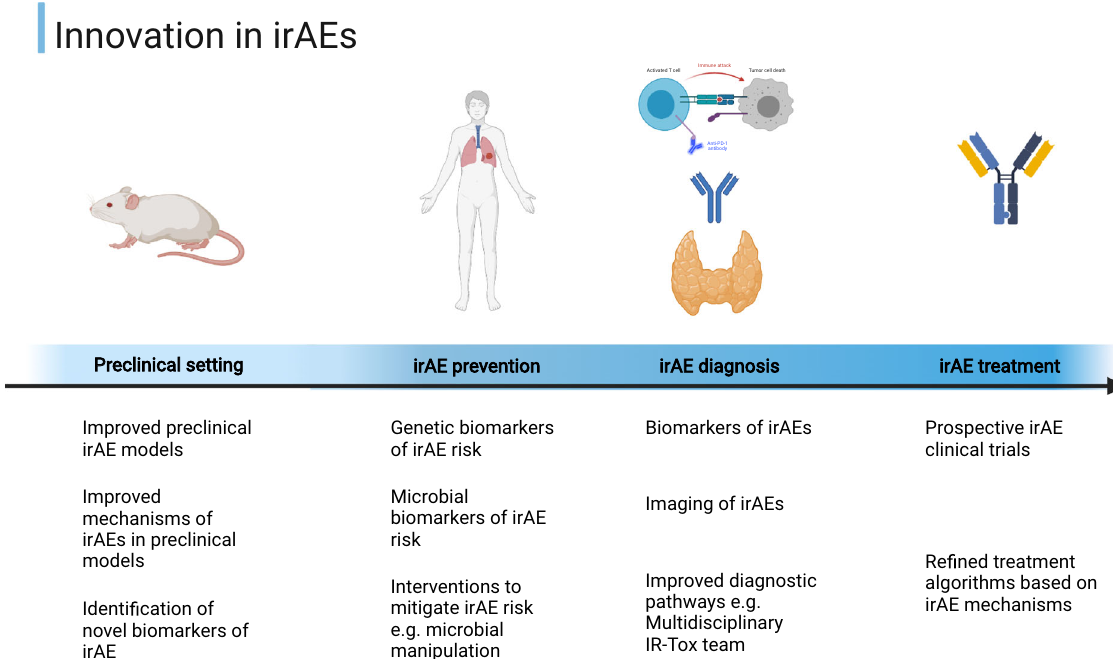
Fig. 1 Innovation in immune-related adverse event research spans the preclinical setting (preclinical models exploring mechanisms and biomarkers), irAE prevention studies (based on genetic or microbial biomarkers and potential interventions), studies that focus on optimizing irAE diagnosis (based on biomarkers or imaging to improve diagnostic pathways), and lastly irAE treatment (prospective irAE trials to inform